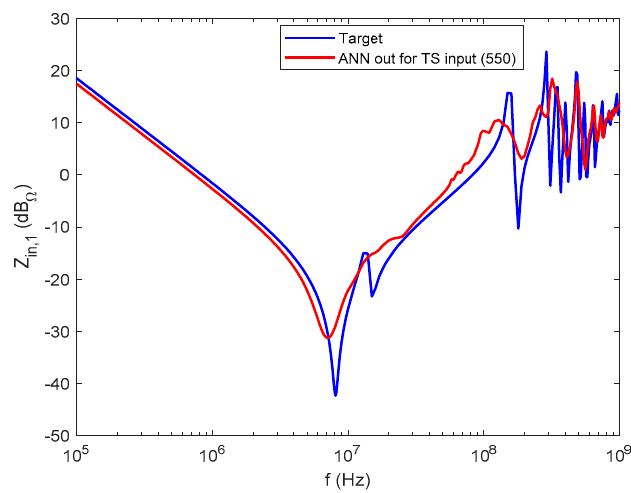
Figure 7. Comparison between the ANN output and the PI simulation results of the impedance at Port 1 for one decap configuration belonging to the TS.